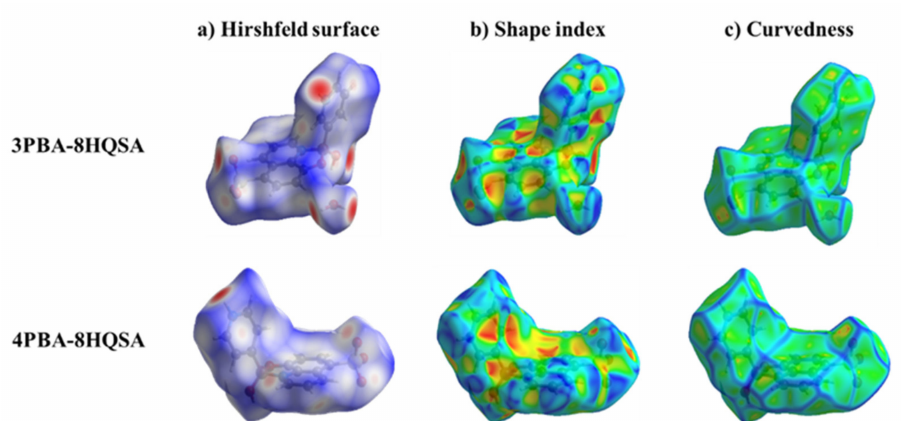
Figure 5. ( a ) Hirshfeld surface ( d norm ), ( b ) shape index, and ( c ) curvedness maps of boronic esters 3PBA-8HQSA ( 1 ) and 4PBA-8HQSA ( 2